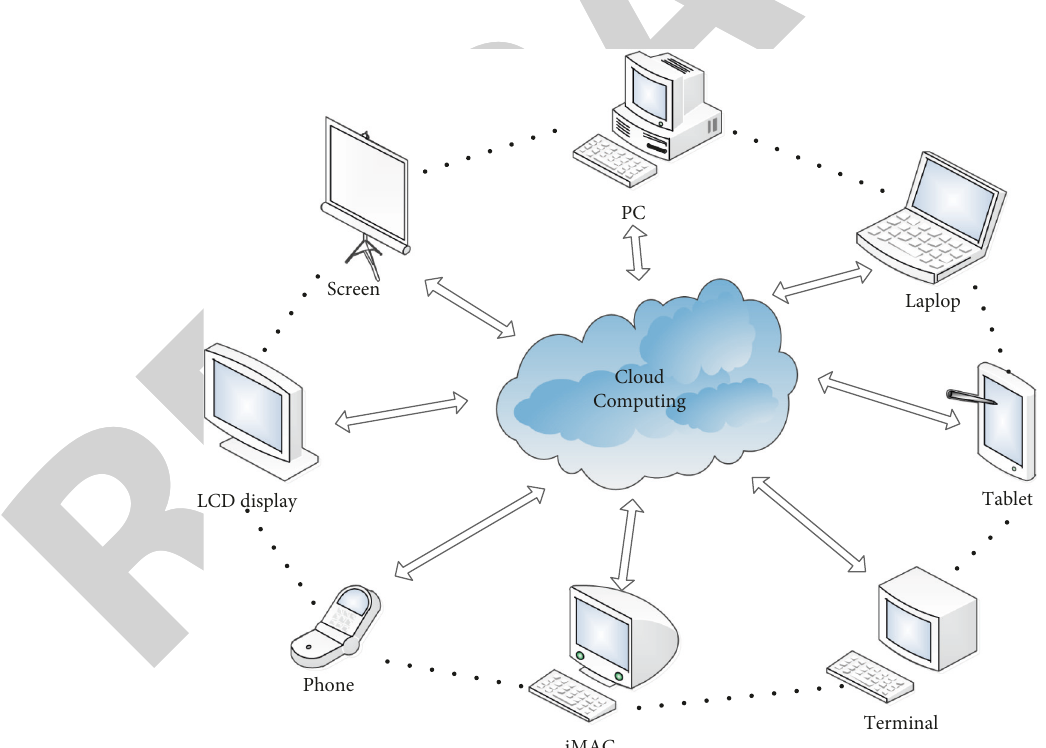
Figure 1: Basic theoretical model of IoT.